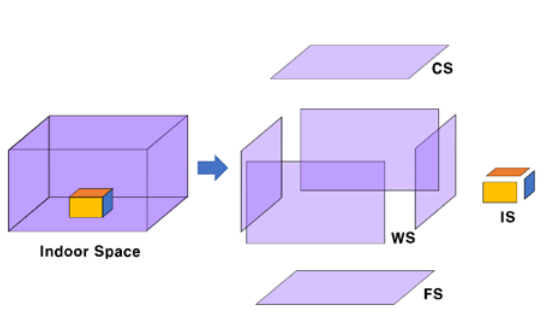
Figure 7. Surface types of indoor spatial data